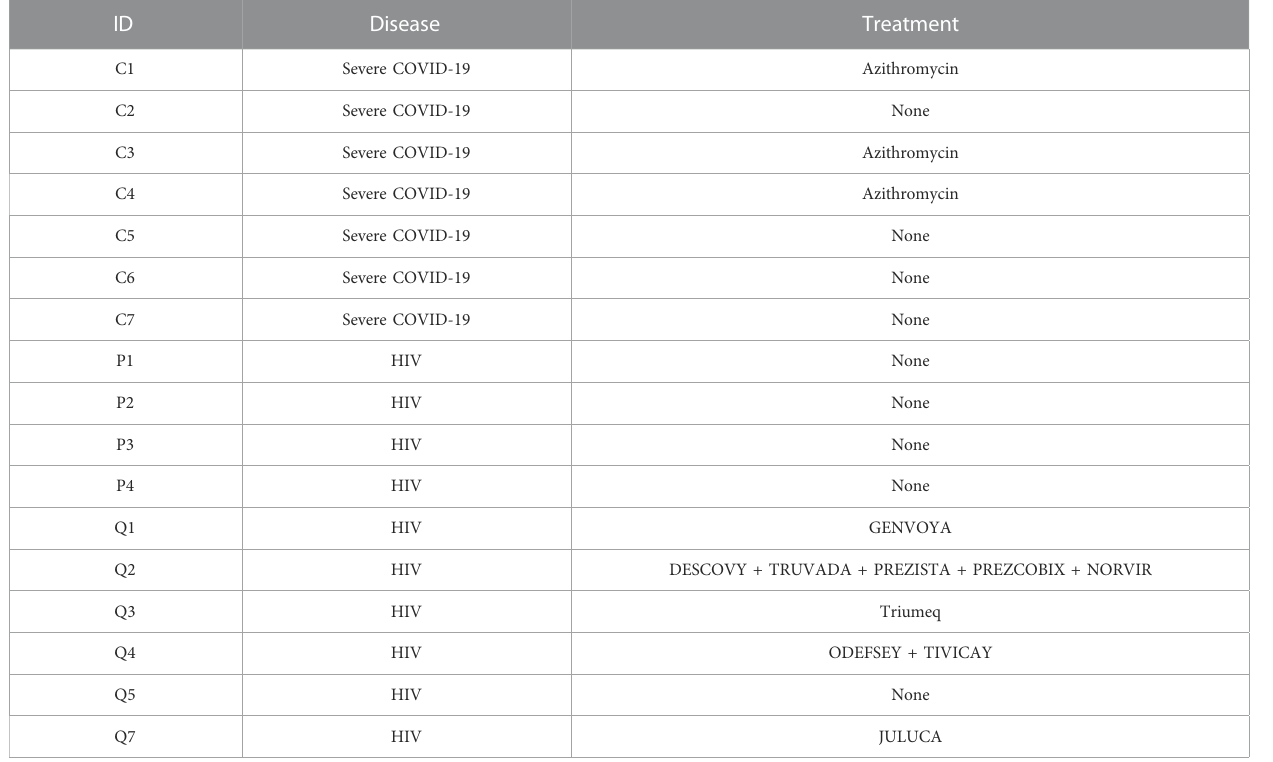
TABLE 4 Treatment information for patients